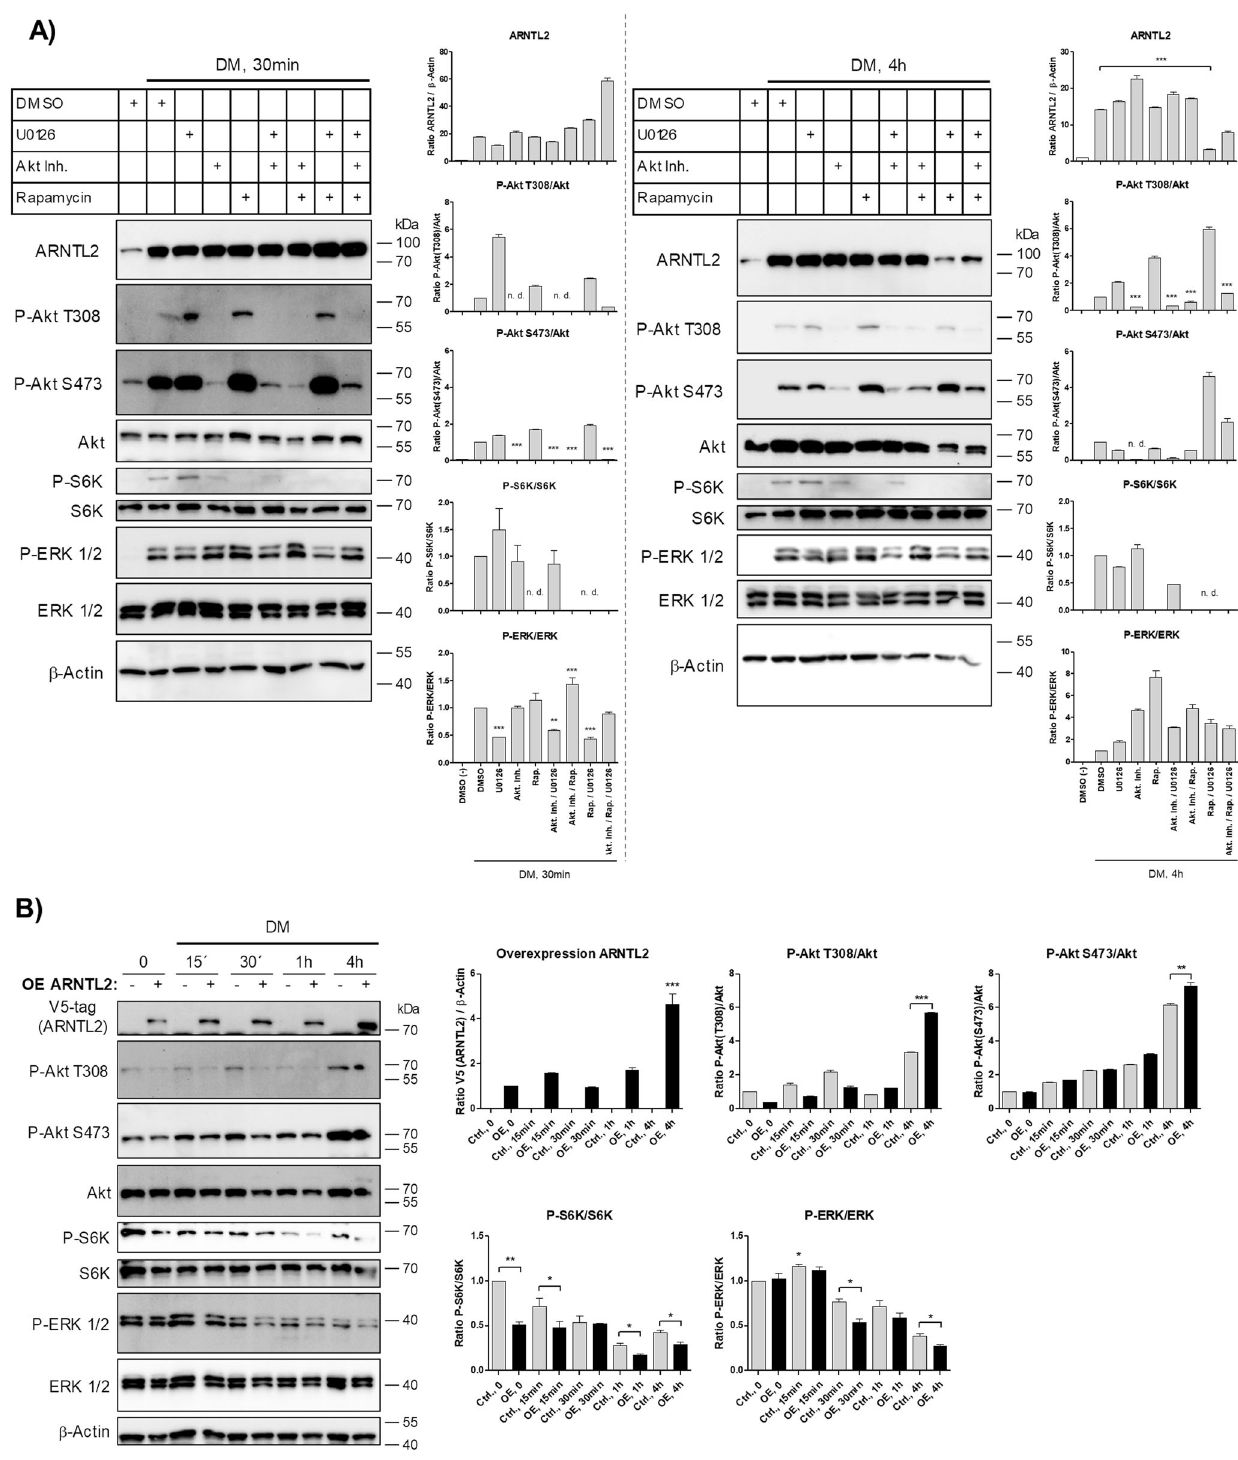
Fig. 5 ARNTL2-dependent feedback mechanism. A Pharmacological inhibition of signaling pathways. Serum-starved ASCs were pre-treated with the indicated compounds or vehicle (DMSO) for 30 min followed by DM stimulation for 30 min (left panel) and 4 h (right panel), respectively. A representative Western blot and densitometry of n = 3 independent experiments (i.e., donors) is shown. β -Actin served as loading control. Values are presented as mean ± SEM of three measurements. Statistical comparison was done using One-way ANOVA and Dunnett´s Multiple Comparison test (vs. stimulated cells pre-treated with DMSO) and the unpaired two-tailed t test (between groups as indicated). B Stimulation of control (Ctrl.; − ) and ARNTL2 overexpressing (OE; + ) ASCs with DM for indicated time points. Left panel: A representative Western blot of n = 3 independent experiments (i.e., donors) is shown. β -Actin served as loading control. Right panel: Densitometry corresponding to the Western blot shown on the left. Values are presented as mean ± SEM of three measurements. Statistical comparison was done with One-way ANOVA with Dunnett´s Multiple Comparison test (vs. t = 0) or the two-tailed paired and unpaired t test between groups as indicated.